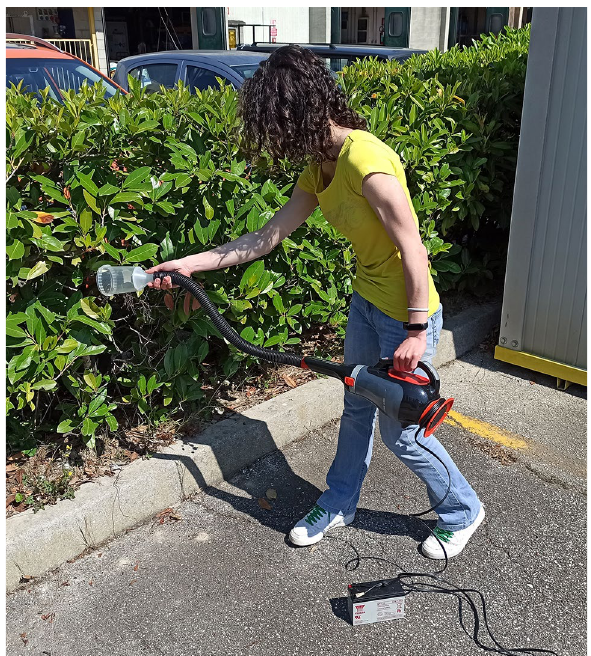
Figure 3. Home-built handheld aspirator (a modified handheld